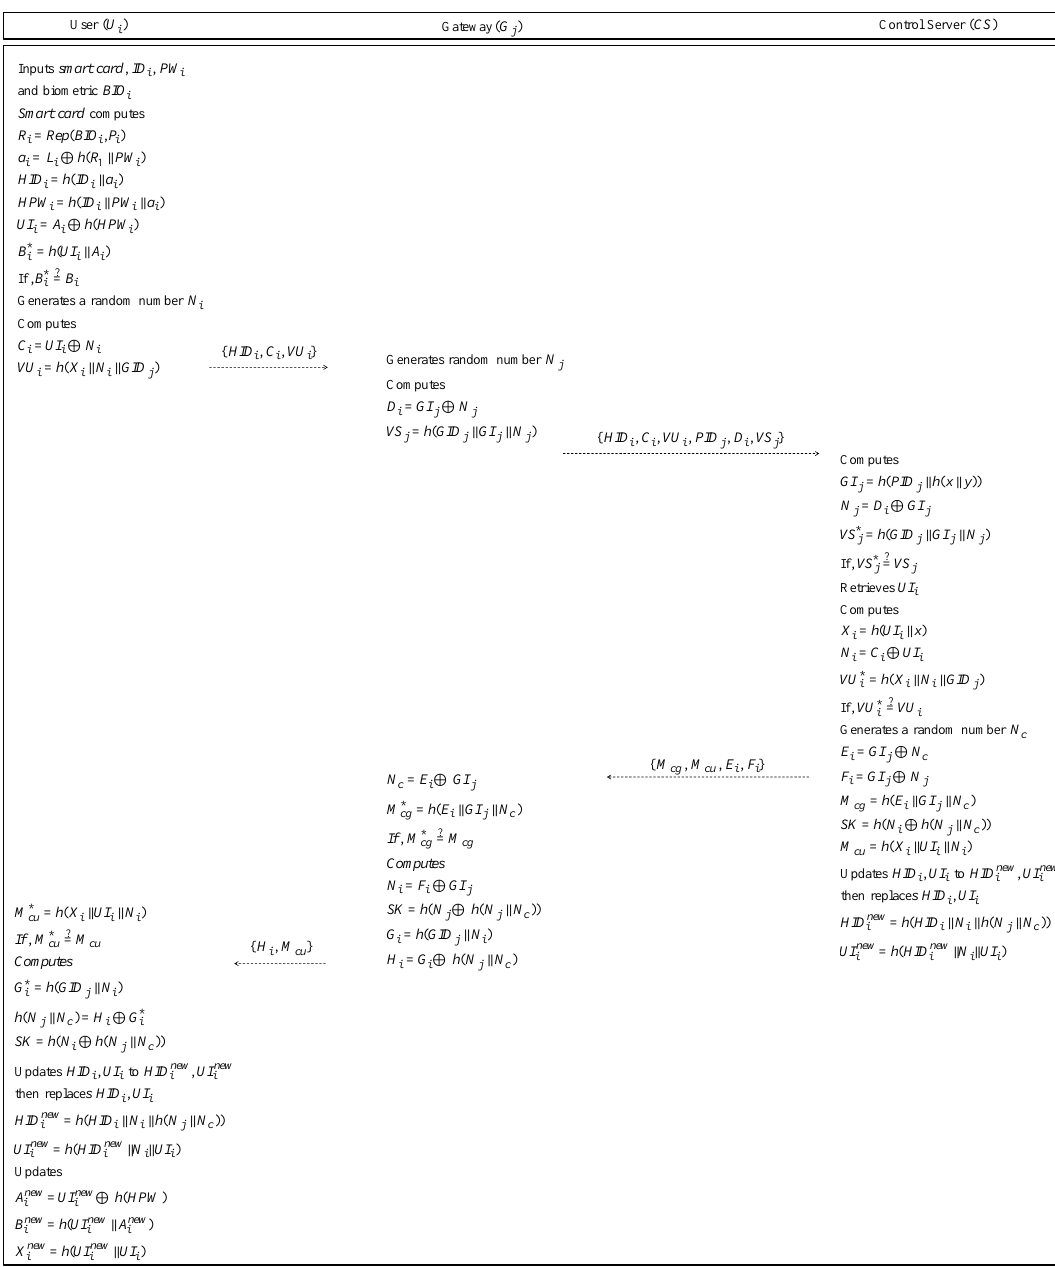
Figure 6. Login and authentication phase of our proposed